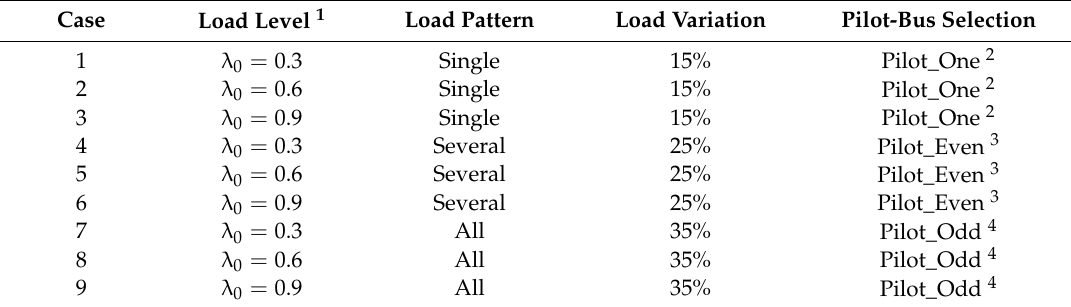
Table 2. Selected scenarios for IEEE 118 ‐ bus.